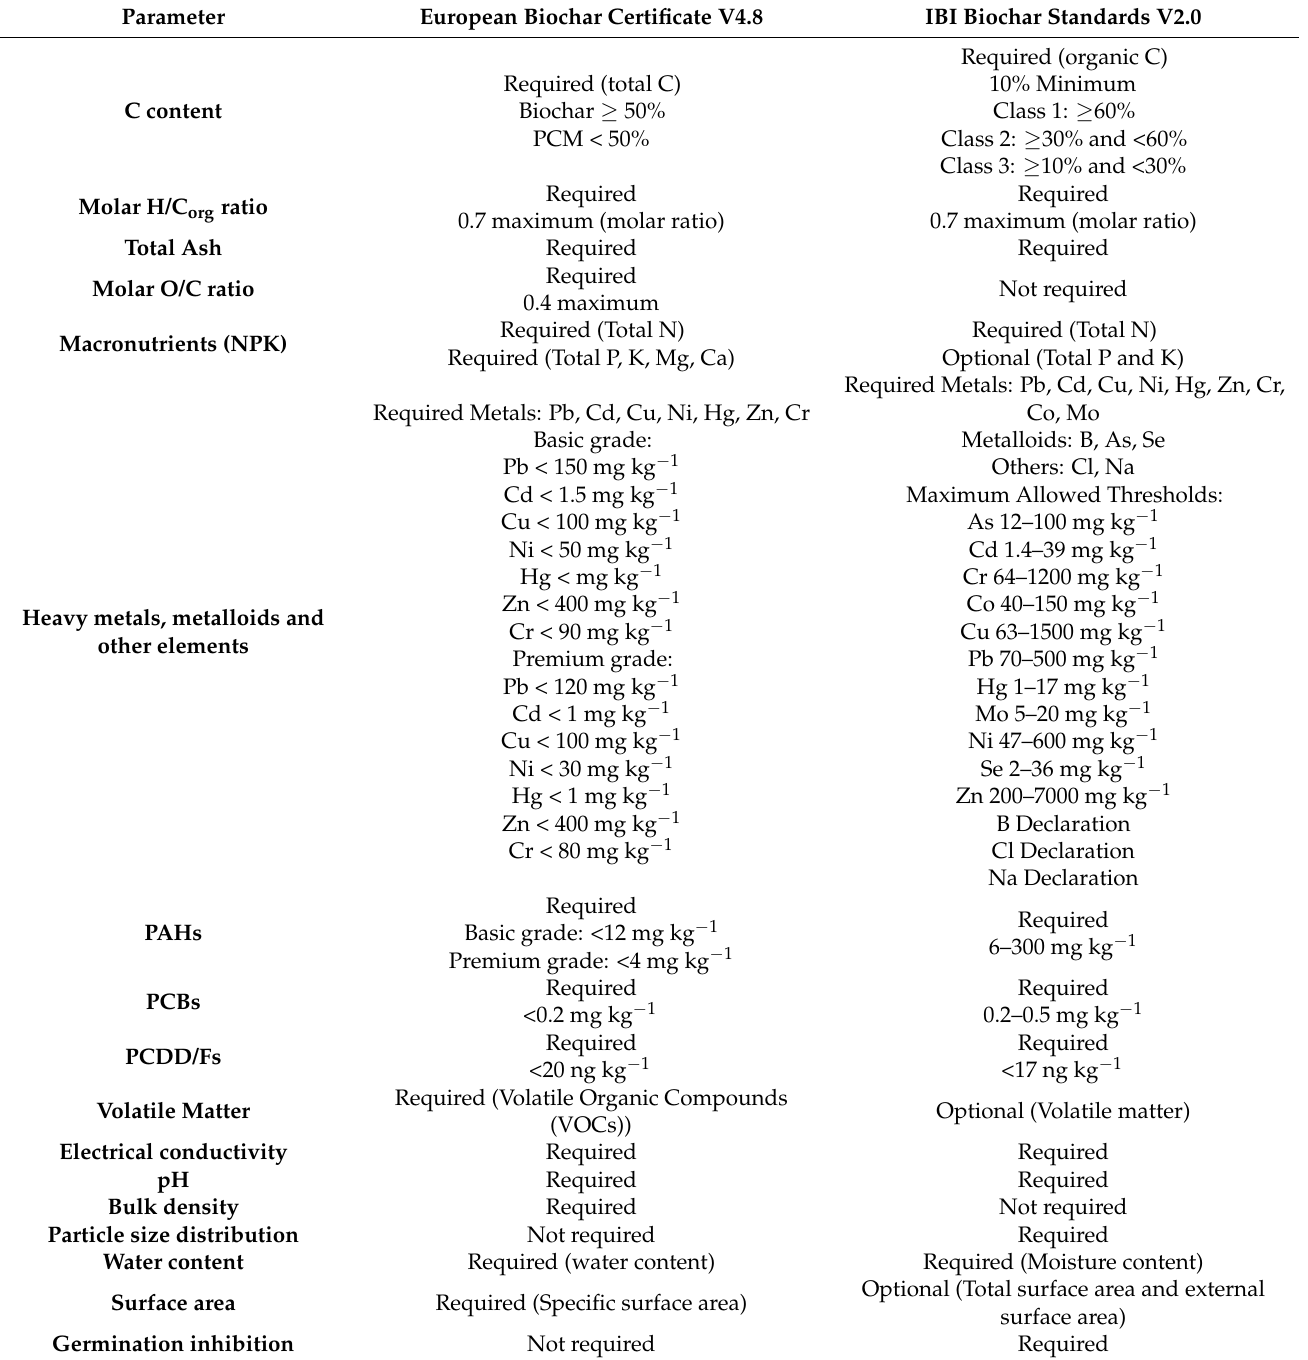
Table 3. Comparison between European Biochar Certificate version 4.8 and IBI Biochar Standard version 2.0